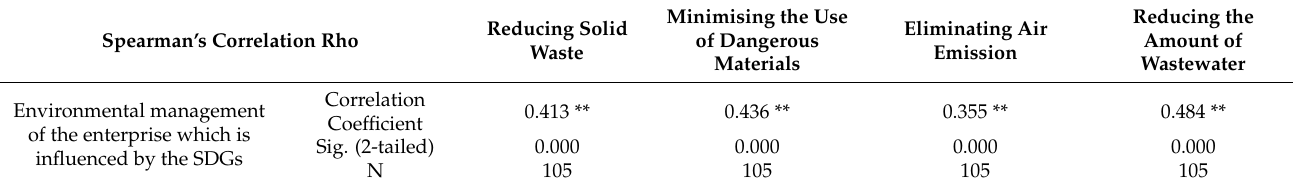
Table 5. Evaluation of null and alternative research